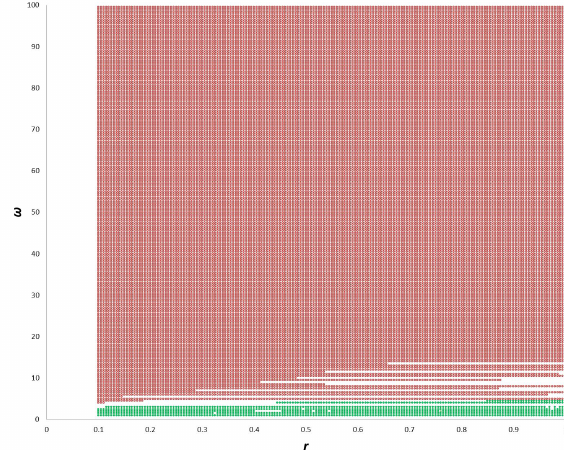
Figure 7: Region diagrams generated by P-T and Runge-Kutta meth- ods ( x (0) = −1.0 , ˙ x (0) = −1.0 )